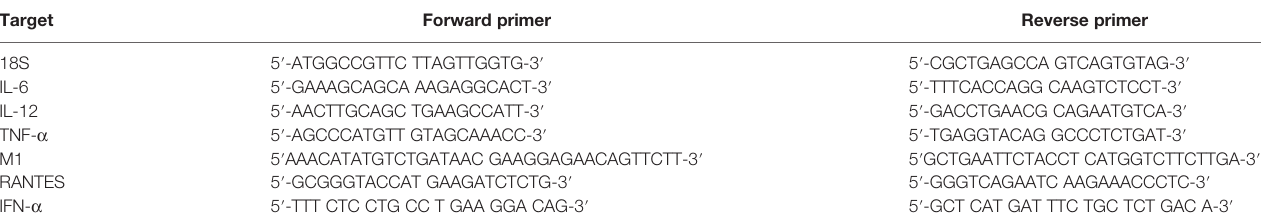
TABLE 2 | Forward and reverse primers used for